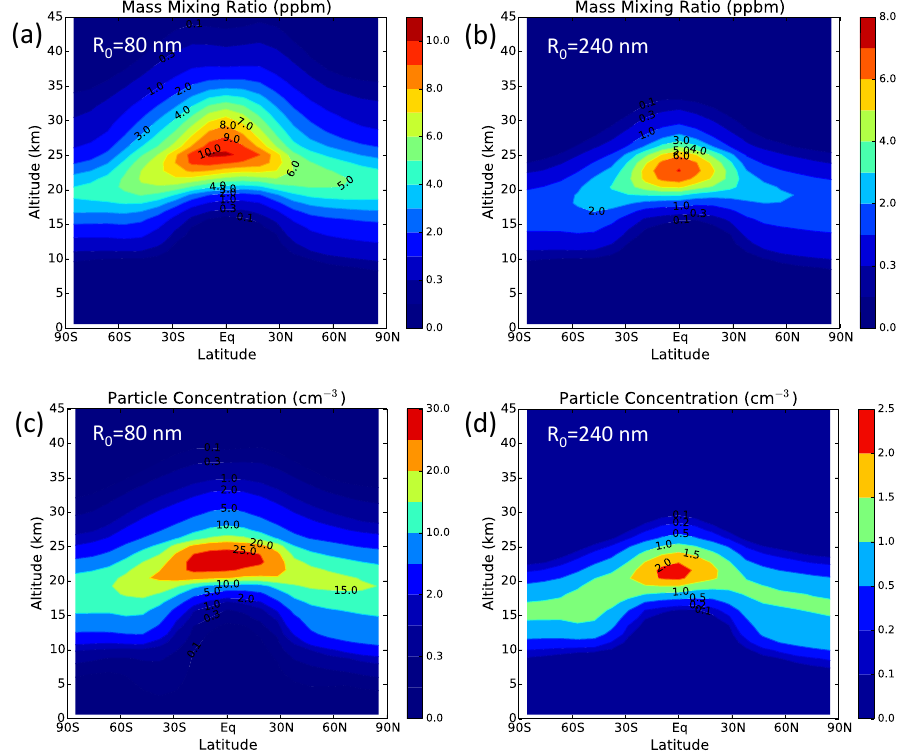
Figure 2. Mass mixing ratio of alumina in ppbm (panels a and b ) and number density of alumina particles in cm − 3 (panels c and d ) with geoengineering injections of 1Tgyr − 1 of 80nm monomers (panels a and c ) and 1Tgyr − 1 of 240nm monomers (panels b and d ) for annual average